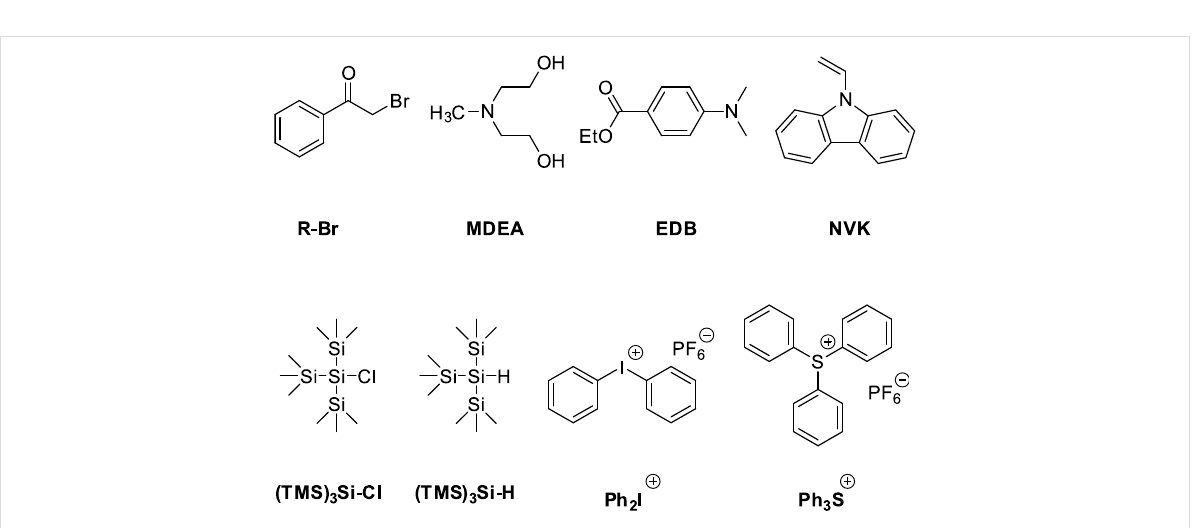
Figure 3: Typical oxidation and reduction agents used through the photoredox catalysis approach in polymerization photoinitiating systems.